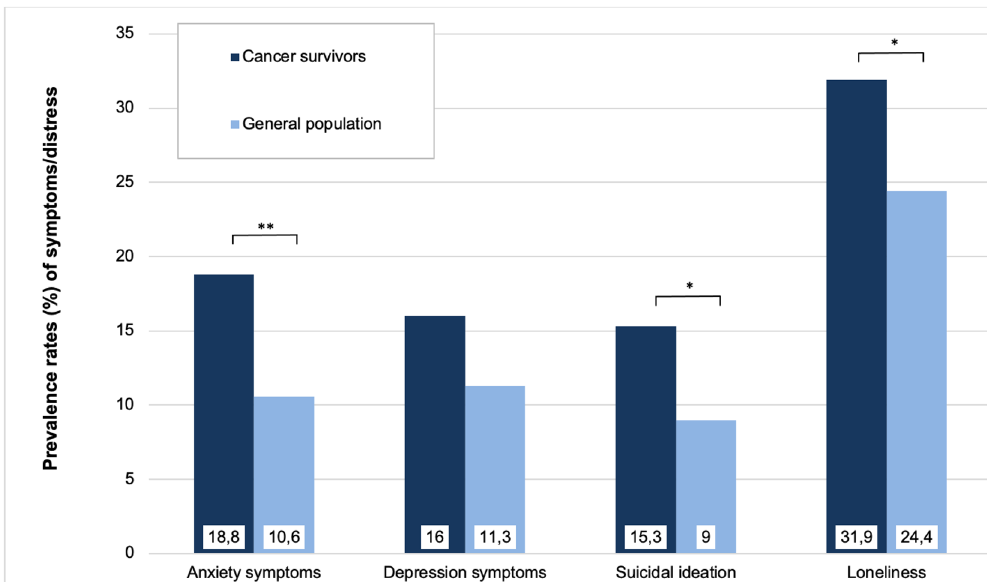
Figure 1. Prevalence rates of anxiety and depression symptoms, suicidal ideation, and loneliness in cancer survivors and the general population. Larger proportions of cancer survivors (dark blue) than of the general population (light blue) reported clinically relevant anxiety symptoms, suicidal ideation, and loneliness. With respect to depression symptoms, there was only a